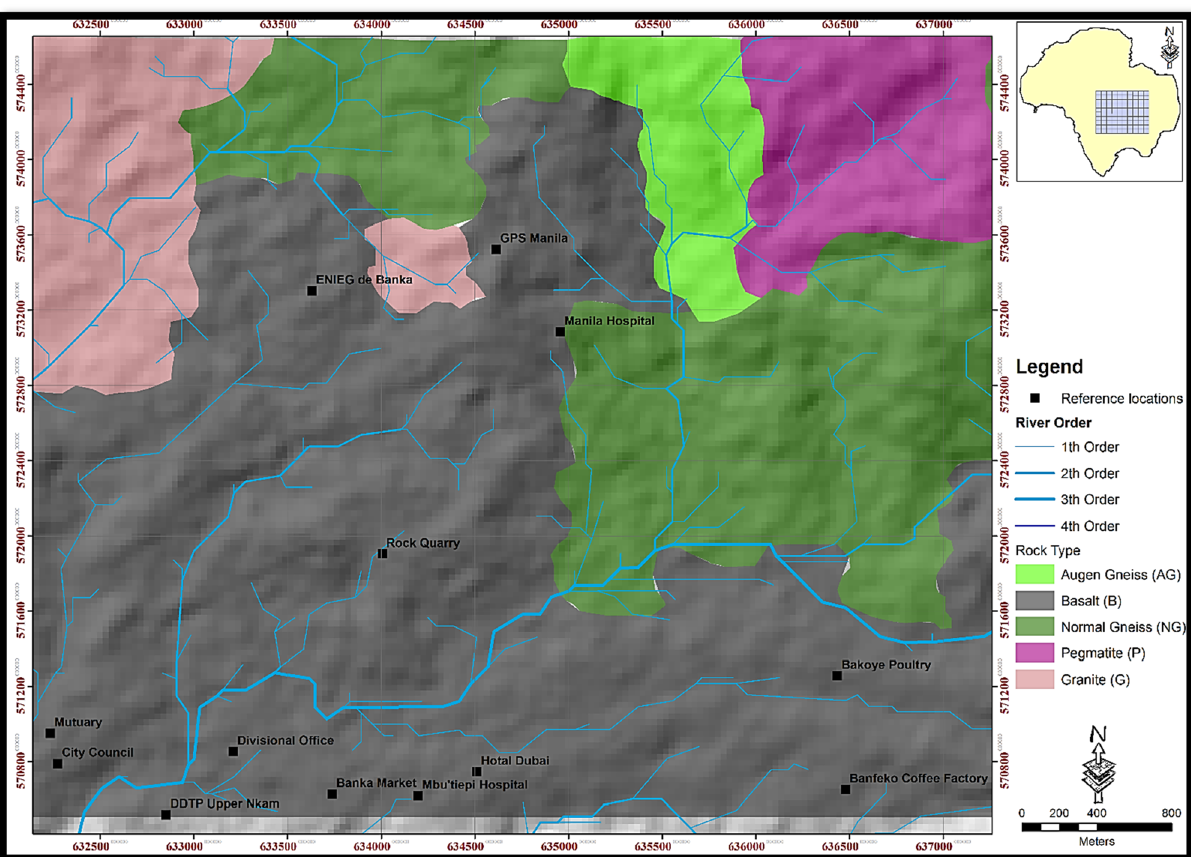
Fig. 6 Geologic map of study